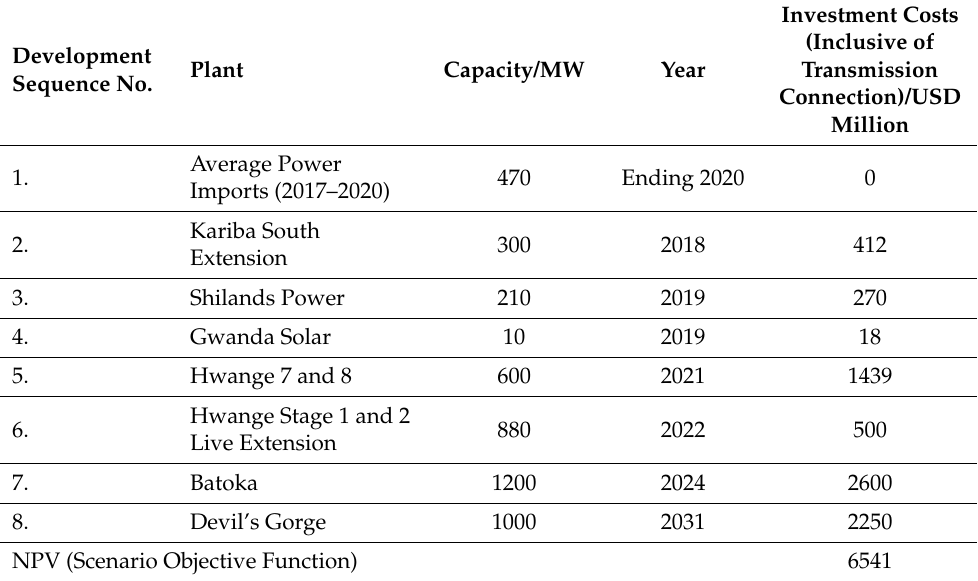
Table 3. Preferred System Development Plan (SDP) of Zimbabwe. Column one indicates the preferred sequence in which the power plants are built. Column two provides the power plant name. Columns three and four indicate the capacity and year in which they come online. While column five indicates the anticipated cost of the